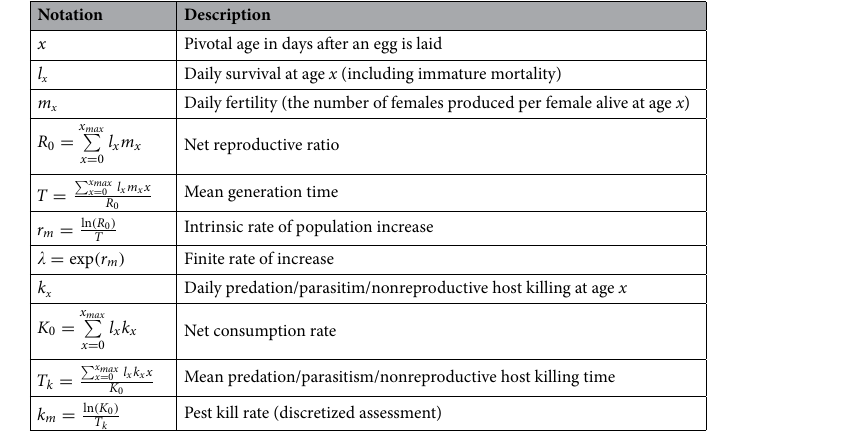
Table 4. Description and formulas for the data-based